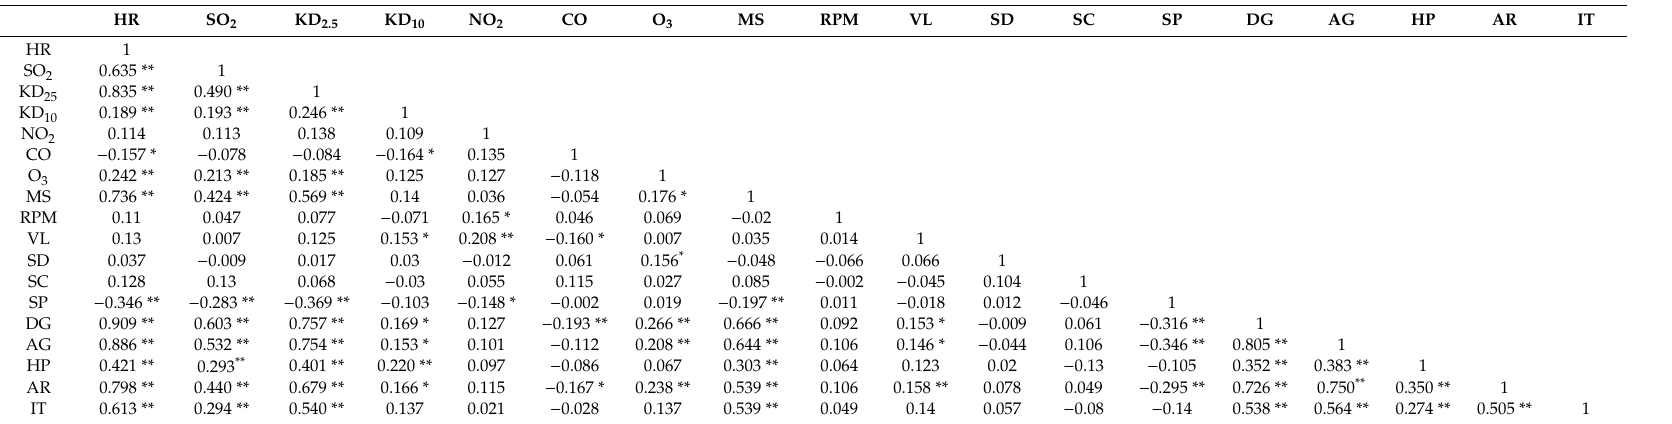
Table 10. Correlational analysis